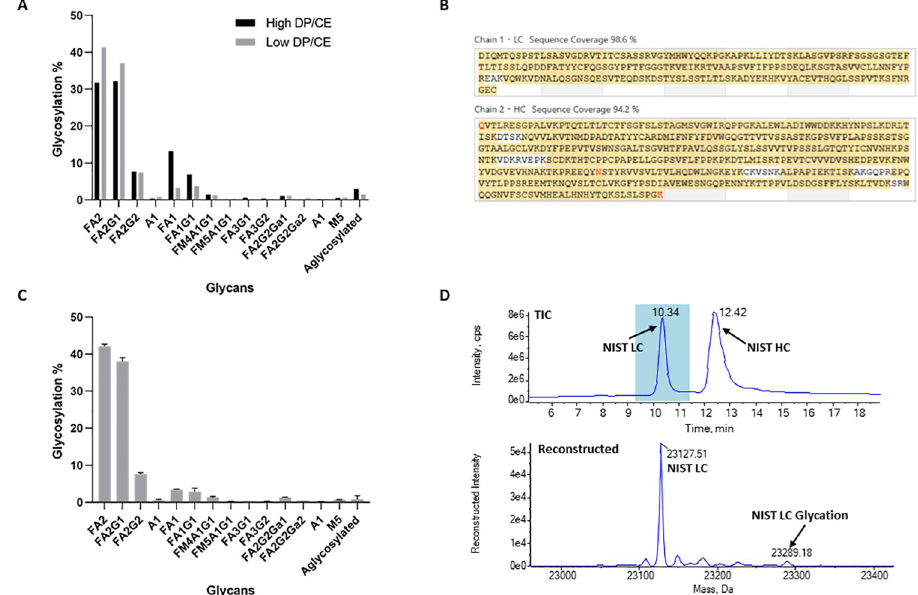
Fig 1. Implementation of the MAM workflow using the NIST mAb reference material. A) Comparison of the glycosylation profiles obtained using in-house previously established peptide ESI-ionization parameters (high DP/CE) and the optimized low DP/CE ionization method; B) Representation of the NIST-RM sequence coverage obtained with the low DP/CE ionization method considering the glycopeptide and MS/MS identifications; C) Repeatability of the glycosylation profiling using the low DP/CE ionization method. Error bars represent the standard deviation (n = 3); D) Light chain (LC) glycation monitored by intact protein analysis of reduced NIST-RM mAb. The peak corresponding to the glycated NIST-RM light chain (+ 162 Da) is indicated in the bottom